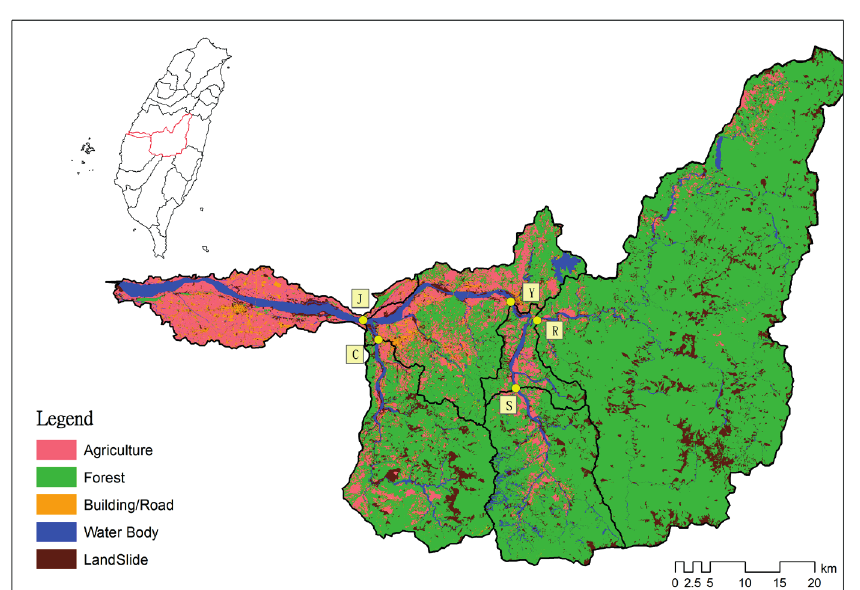
Fig. 2 Land use in the Choshui River watershed. Also shown are the locations of the five water- sampling stations (J, Y, R, C, S) occupied during typhoons Mindulle and